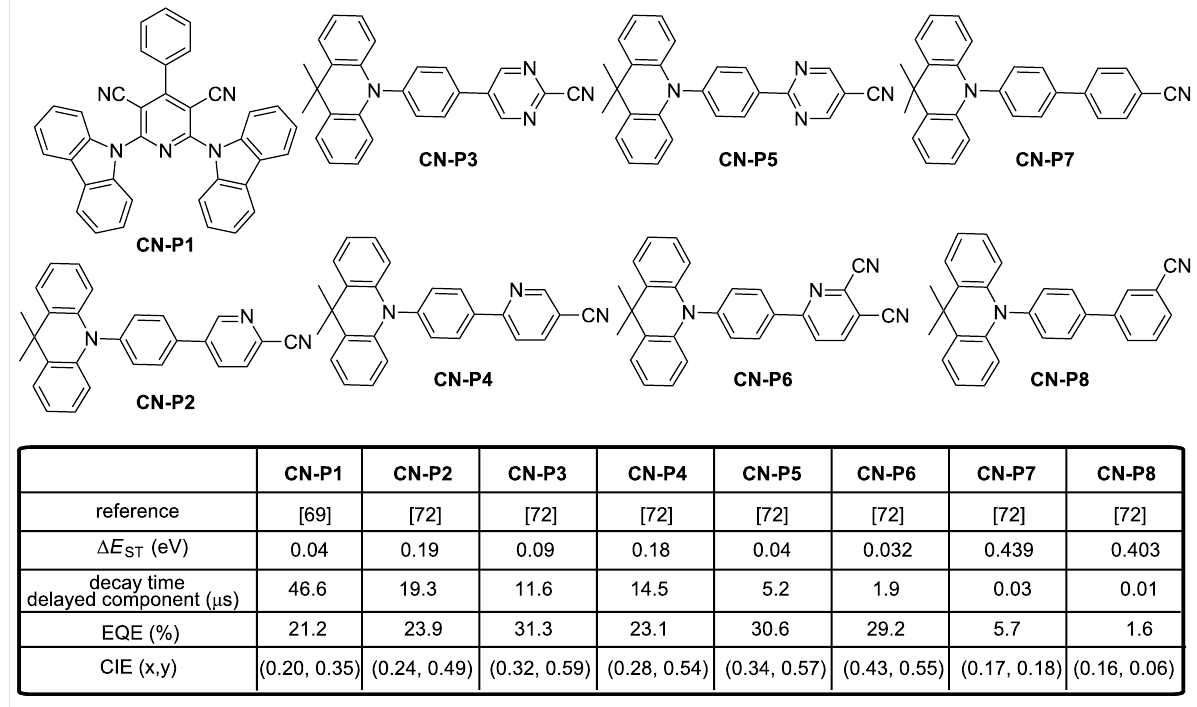
π -conjugation and localizing the HOMO level on the